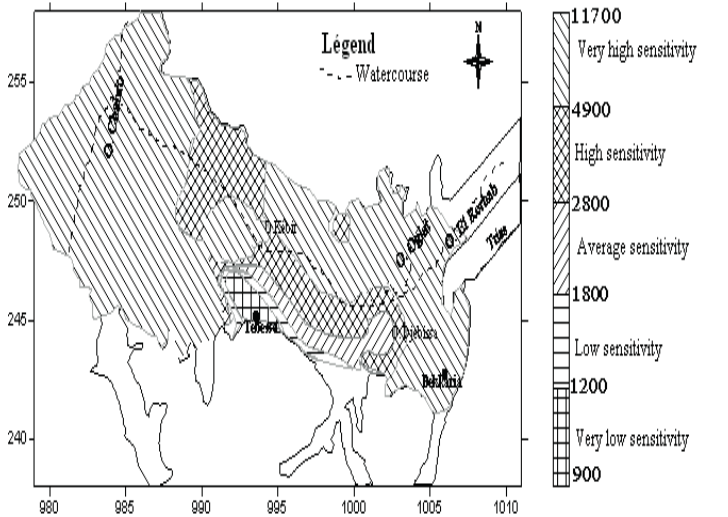
Fig. 6 Map of the sensitivity index of water for the AEP to the Tebessa